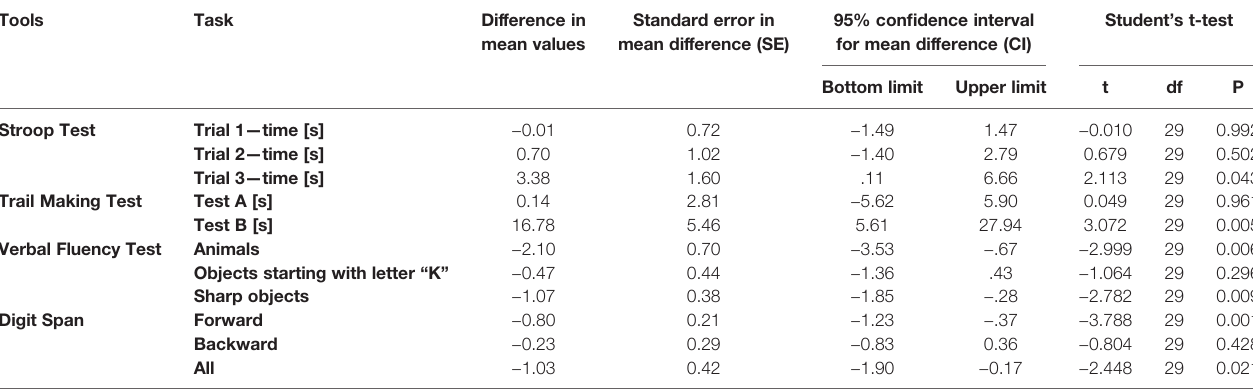
TABLE 3 | Comparison of results of cognitive function measurement before and after dietary intervention (MSwithDI group).